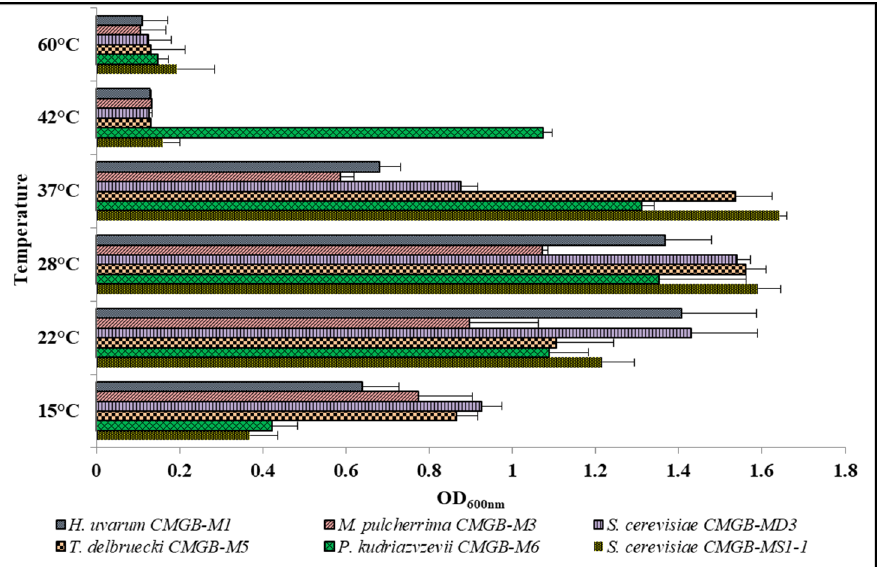
Figure 5. Growth rate of yeasts isolated from wort sediment after 24 h of cultivation at different temperature values. temperature